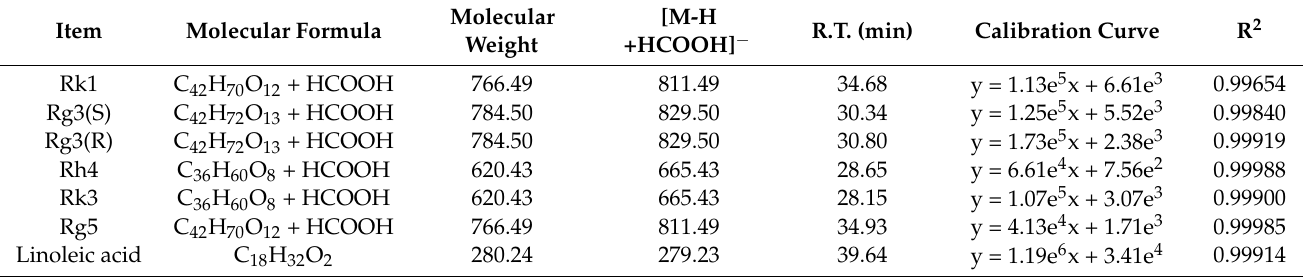
Table 1. Selected ion monitoring conditions of ninth repetitive steaming for ginsenosides and linoleic acid. Item Molecular